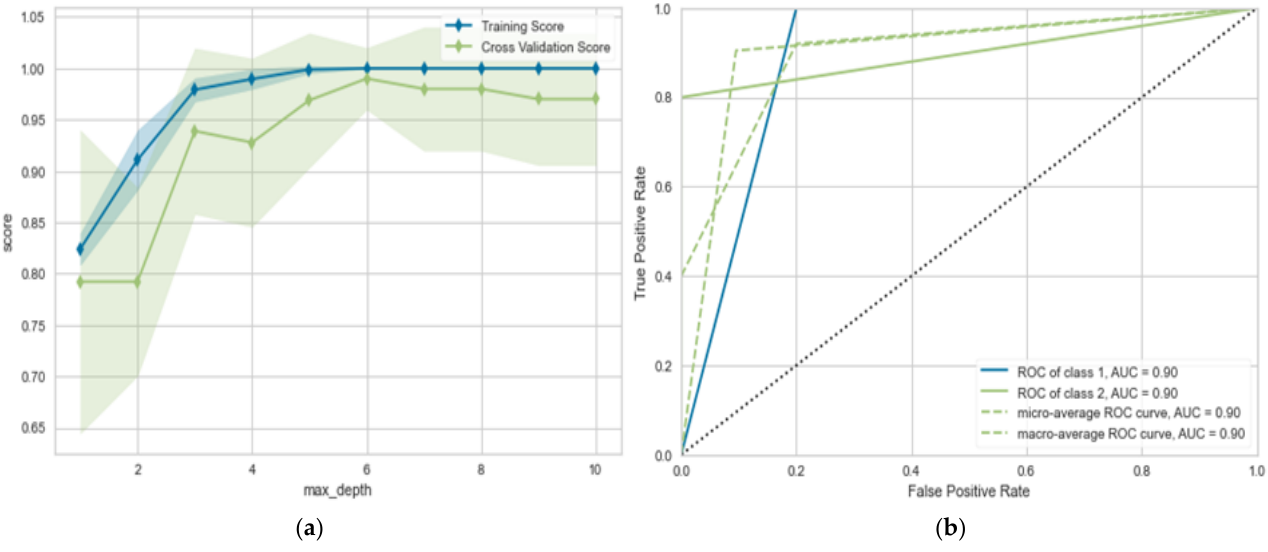
Figure 7. ( a ) Learning curve for the proposed model; ( b ) validation curve for proposed model (prognosis after 6 months).